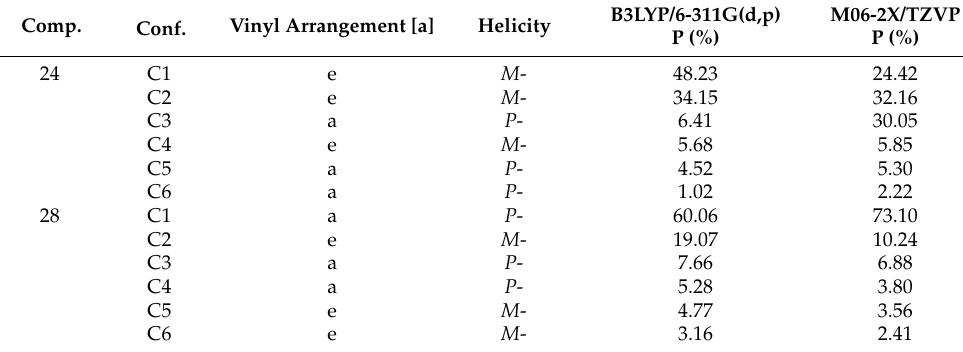
Table 1. Conformational analysis of compounds 24 and 28 using two approaches. Comp.